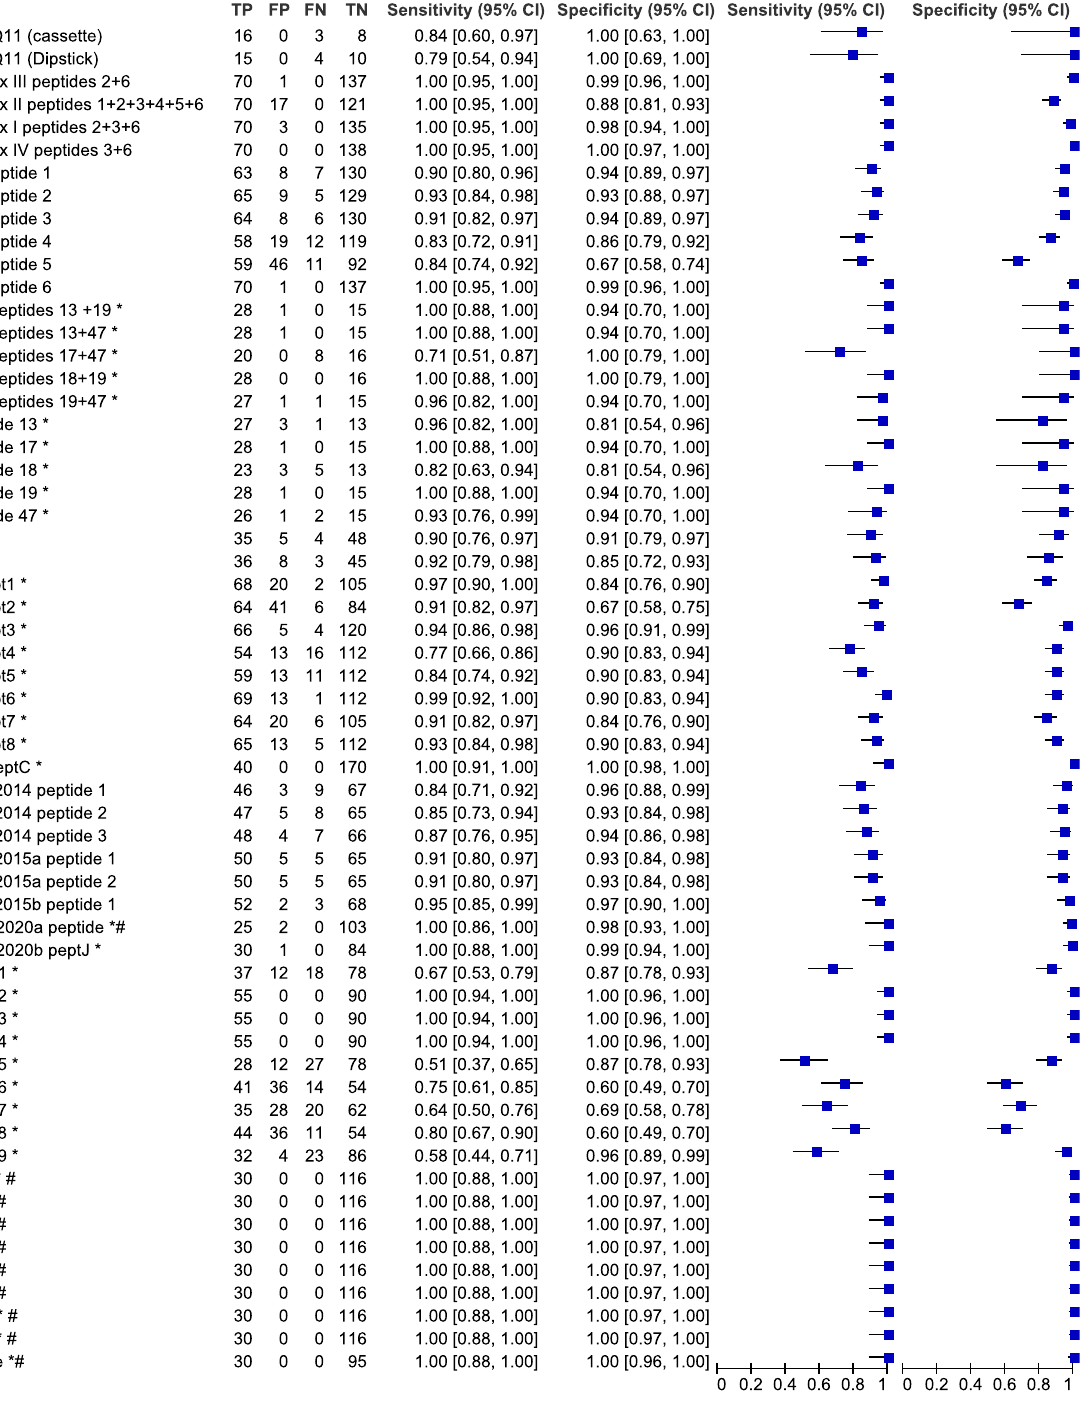
Figure 2. Forest plot representing percentage of sensitivity and speci fi city of different peptide-based tests for visceral leishmaniasis (VL) diagnosis. * studies where the counts of true positive (TP), false positive (FP), false negative (FN), and true negative (TN) results were estimated from the sensitivity and speci fi city values. # studies where sensitivity and speci fi city were recalculated considering all non-cases in a single control